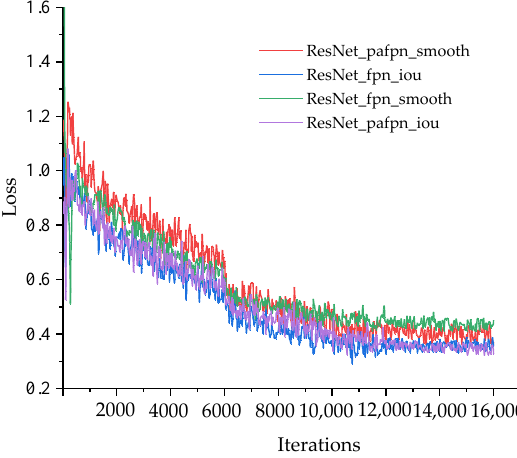
Figure 6. Training loss curves of different models.